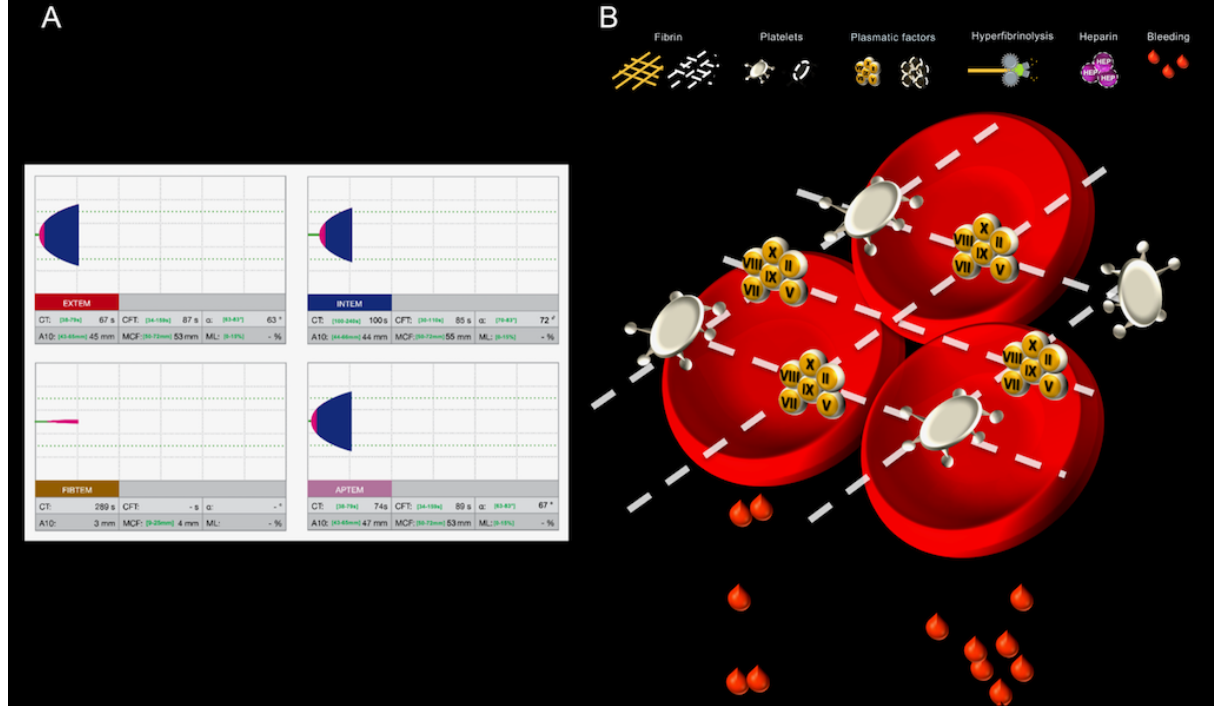
Figure 2. Example of a standard rotational thromboelastometry (ROTEM) presentation with a corresponding Visual Clot. Adhering to the coagulation algorithm used at the University Hospital Zurich, this hemostatic state represents fibrin